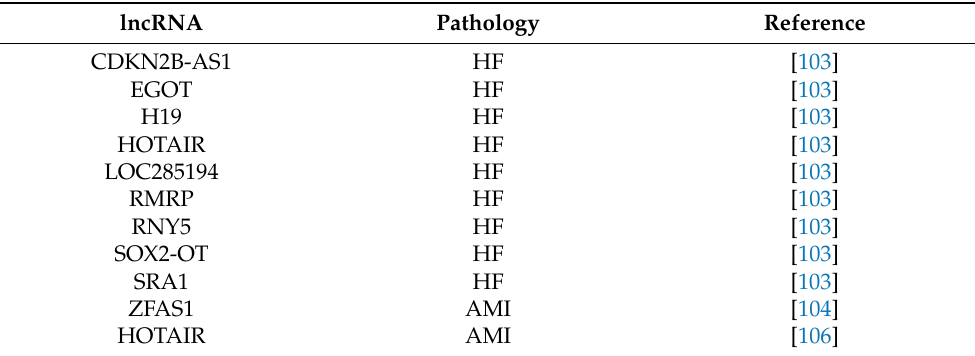
Table 2. Long non-coding RNA (lncRNA) in ischemic heart